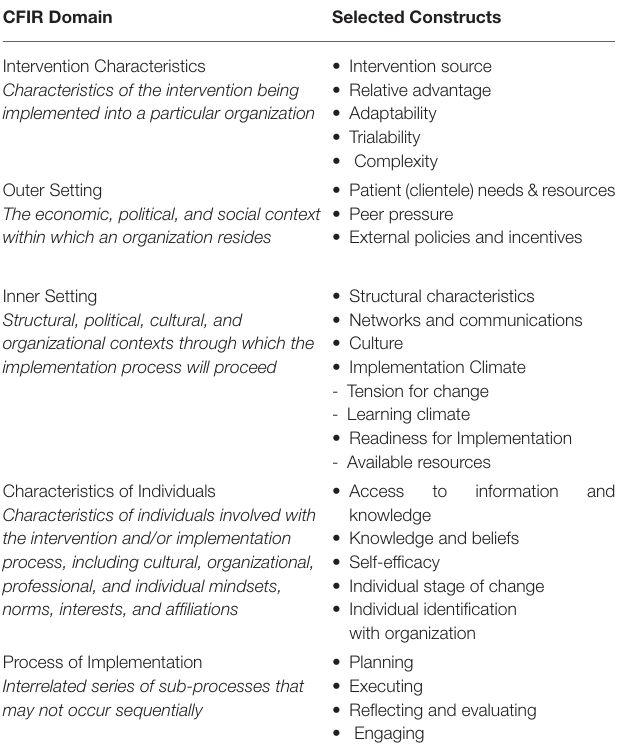
TABLE 1 | Selected domains and constructs - consolidated framework for implementation research